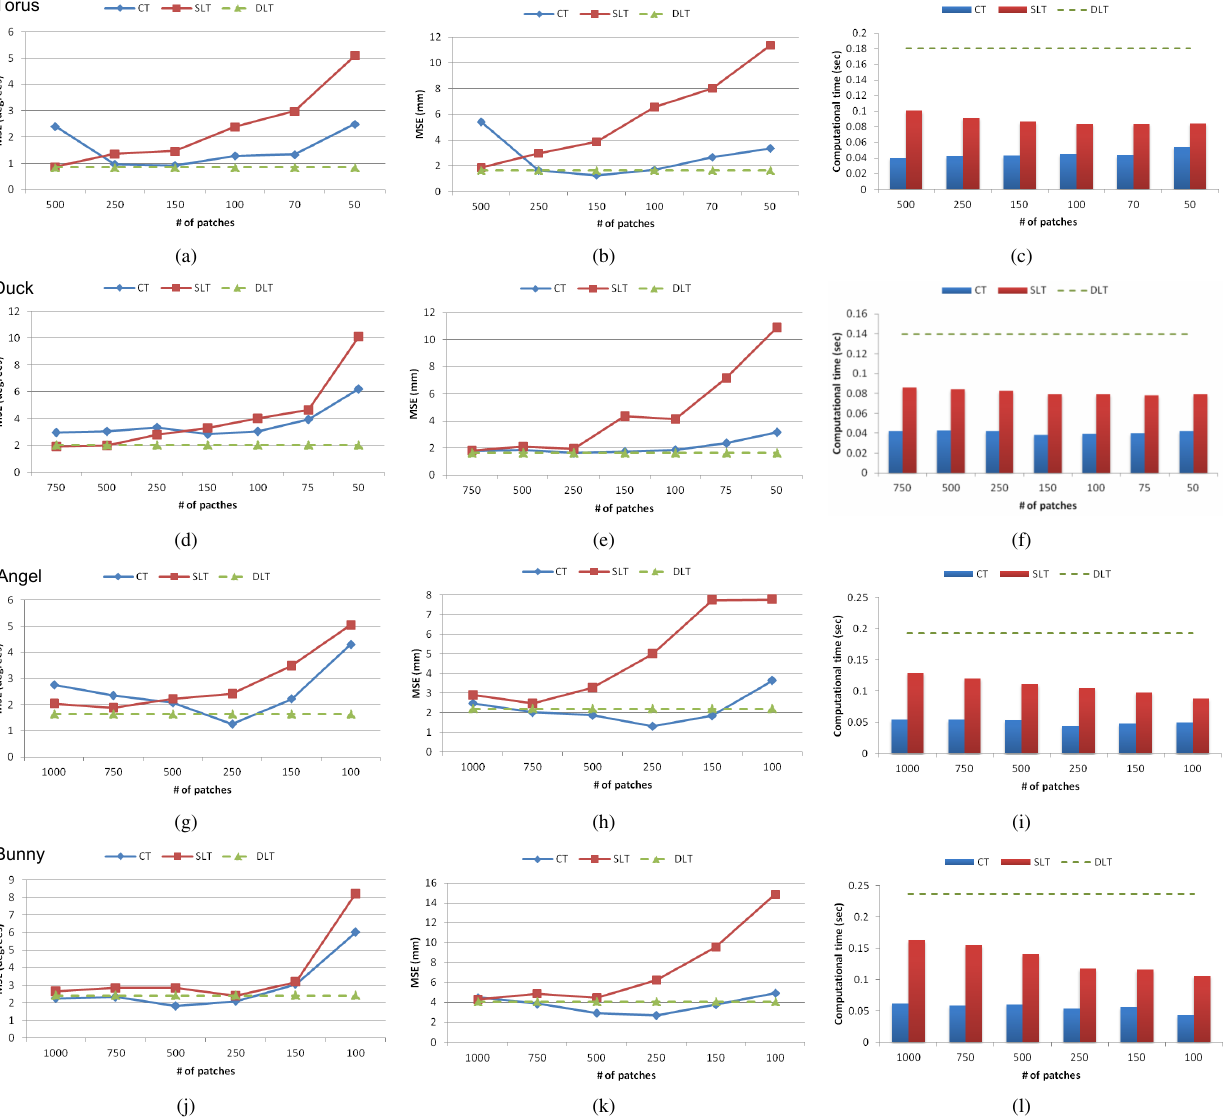
Fig. 12. Results for accuracy and computational time of experiment A, where each row represents one object: torus, duck, angel and bunny, in this order. Left : MSE for the rotation in degrees. Middle : MSE for translation in mm. Right : Average of the computational